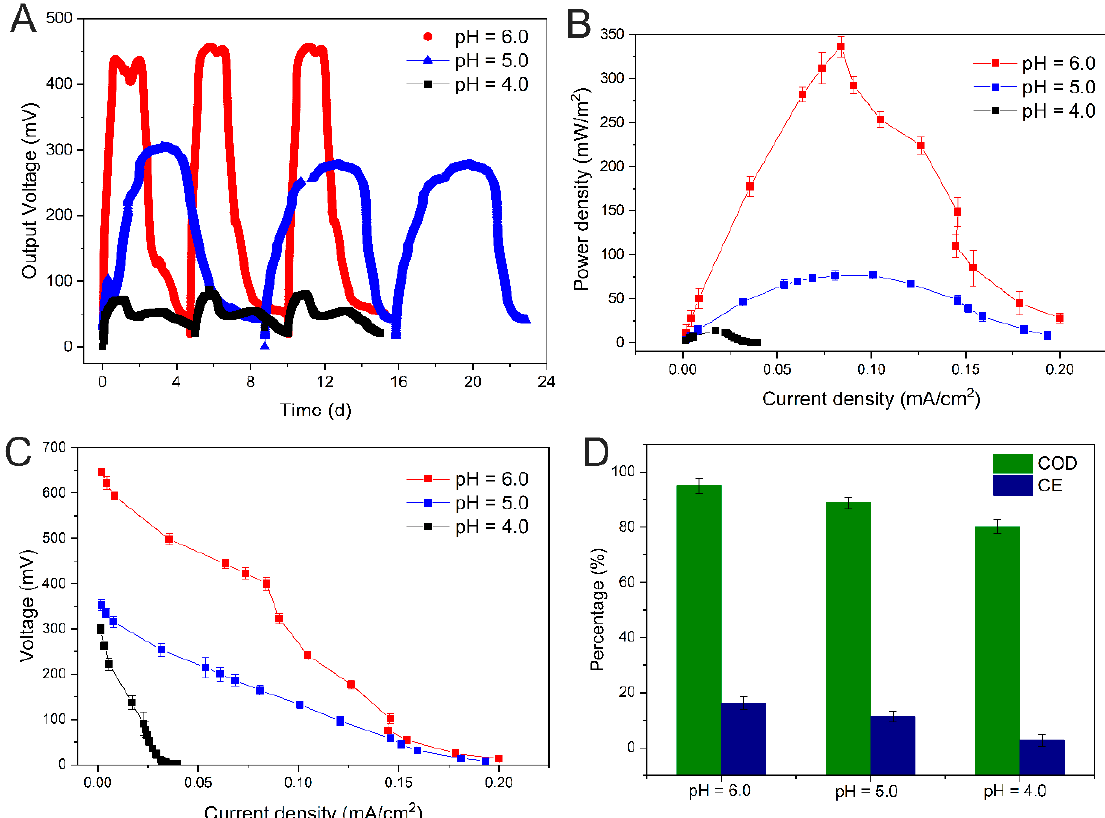
Figure 1. Output voltage ( A ), power density ( B ), polarization curves ( C ), and COD removal efficiency and CE ( D ) of single-chamber MFCs under different pH stresses.